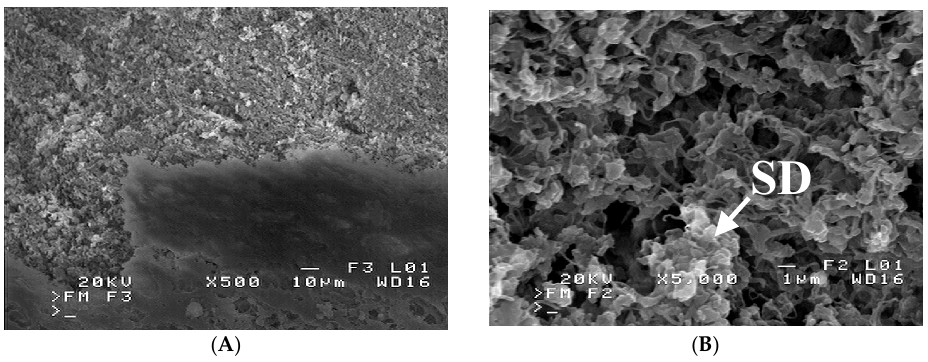
Figure 11. SEM images of membrane external surface: ( A ) a part of wall was detached (top of figure), ( B ) detached wall with salt deposit (SD). Module MD2.